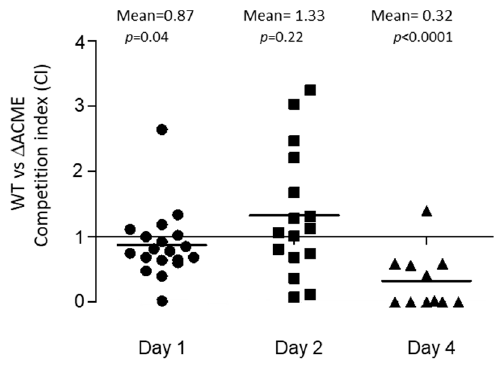
Figure 5. Strain 2406 WT vs. ∆ ACME competition experiments showing survival on the surface of mouse skin. The mean CIs for WT vs. ∆ ACME on mouse skin was 0.87 on Day 1 ( p = 0.04), 1.33 on Day 2 ( p = 0.22) and 0.32 on Day 4 ( p < 0.0001), indicating that ∆ ACME had slow death rates on the surface of mouse skin. Mann–Whitney tests were performed to determine significant difference between the CI and the value 1.